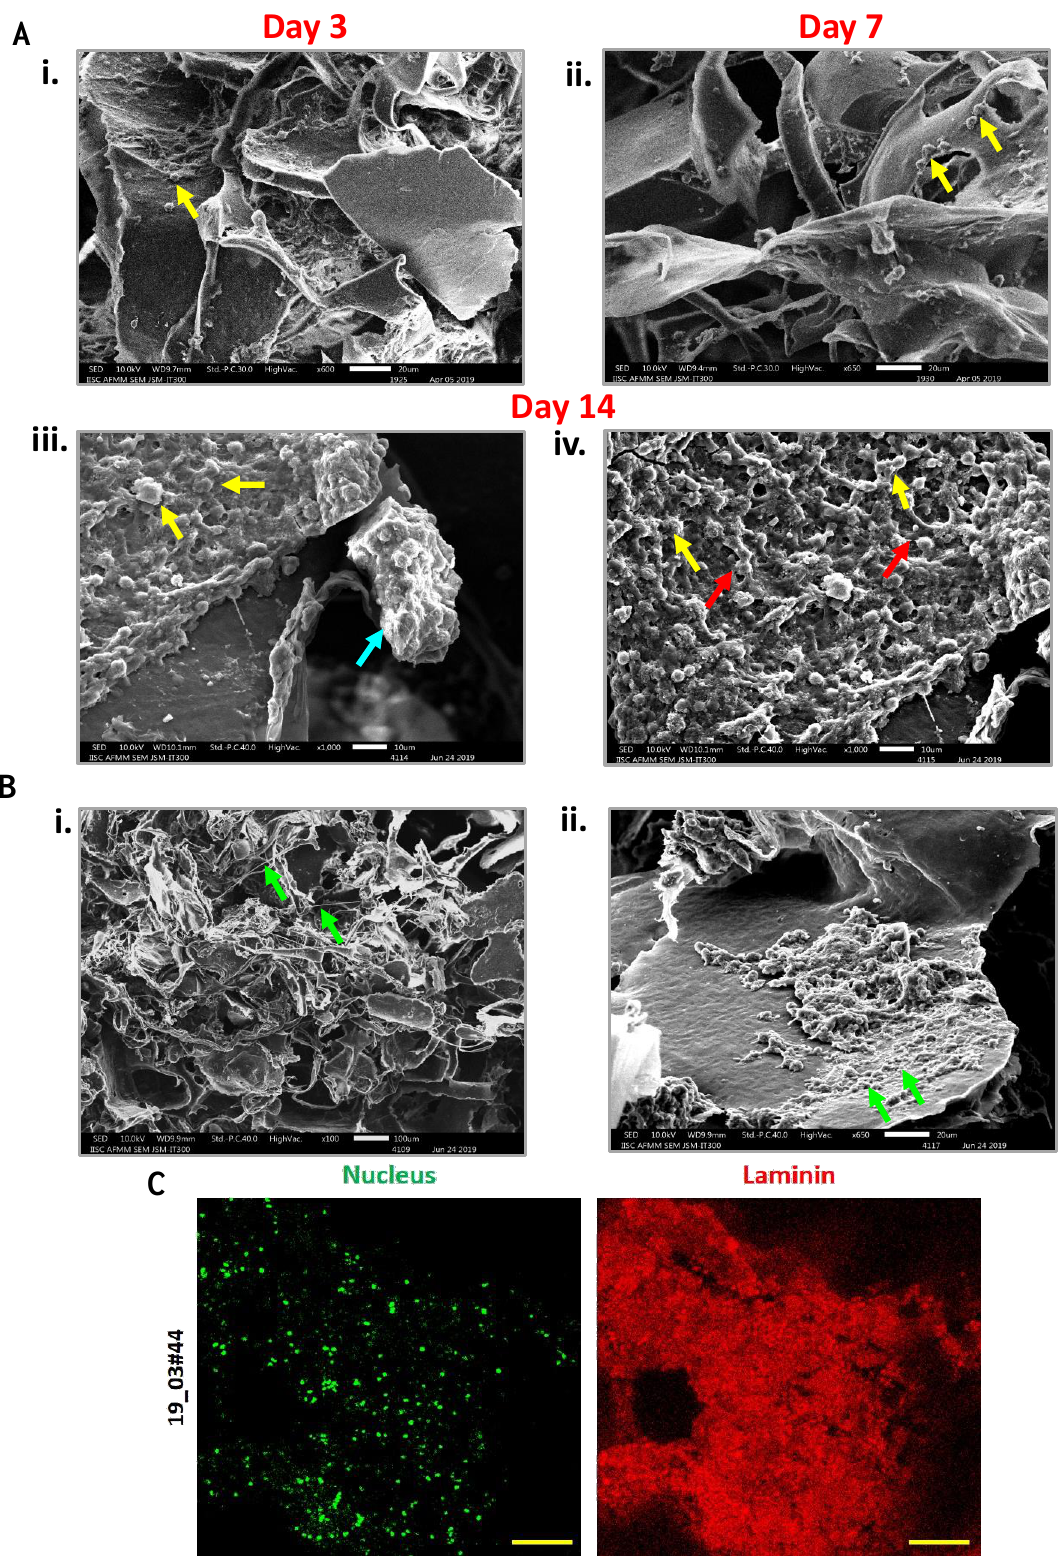
Figure 2. Detection of cell clusters and extracellular matrix (ECM) deposition in 3D PCL scaffolds. ( Ai–iv ) SEM micrographs showed the presence of increasing numbers of cells in day 3, day 7 and day 14 cultures of red blood cell (RBC)-depleted nucleated cell pellet of patient samples cultured in 3D PCL scaffold (yellow arrows). Formation of clusters ( iii ) (blue arrow) and the presence of